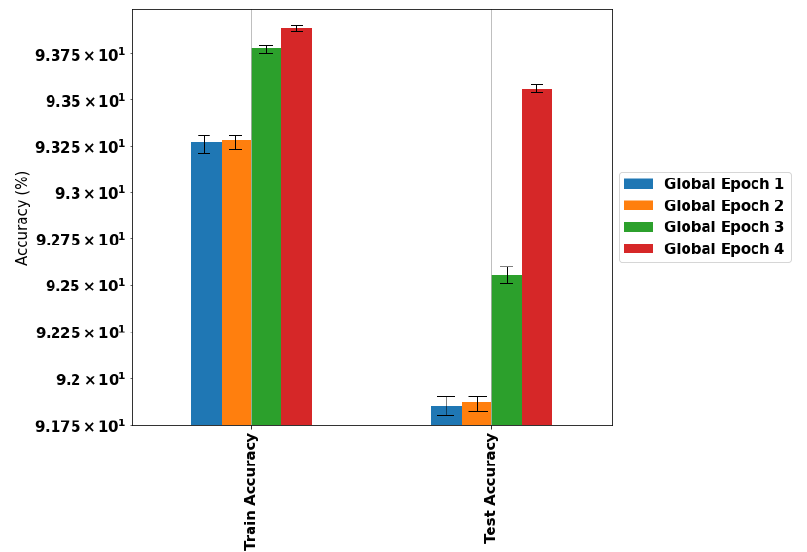
Figure 9. Experiment 3.1: Local learning effect with three agents, one local epoch, and four global